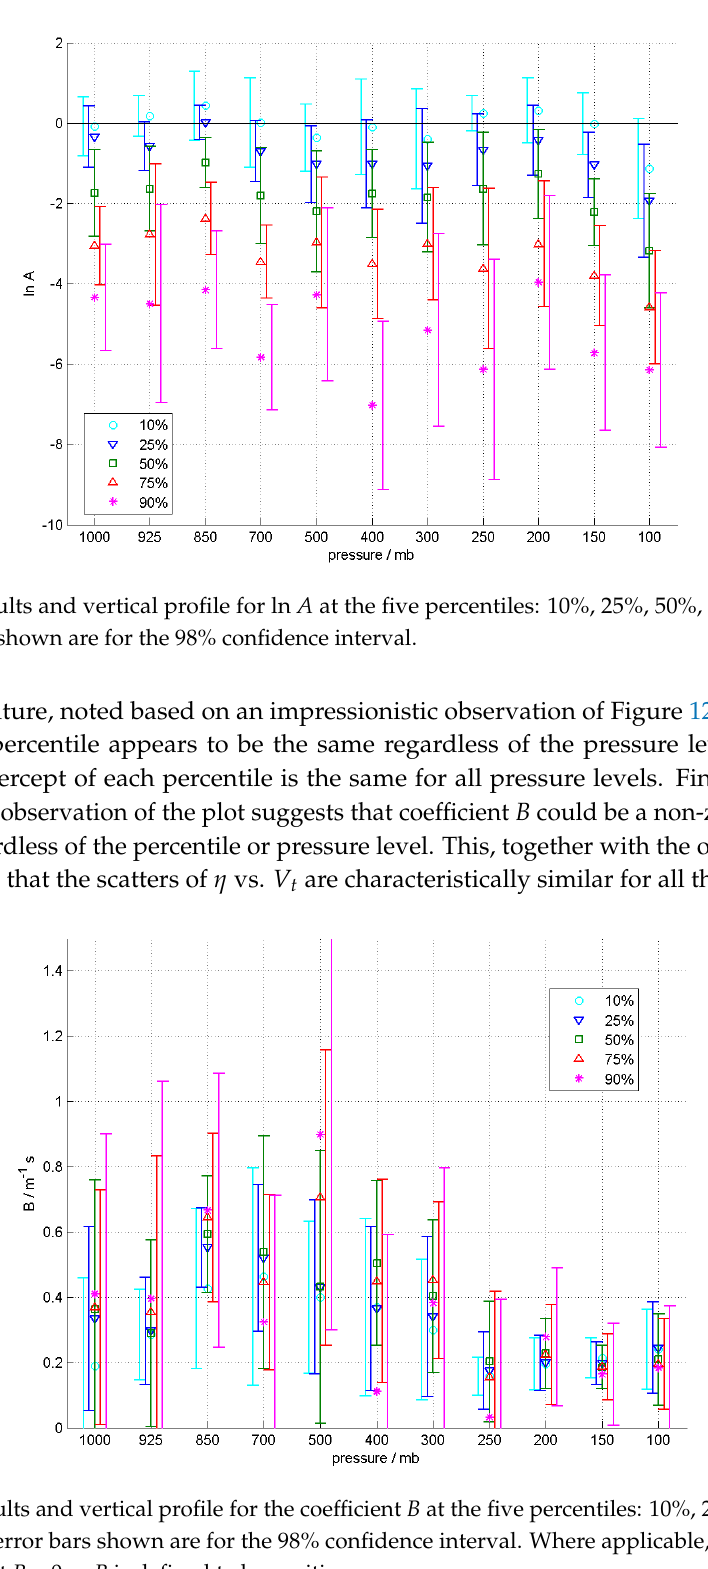
Figure 11. Results and vertical profile for the coefficient E at the five percentiles: 10%, 25%, 50%, 75%, and 90%. The error bars shown are for the 98% confidence interval.